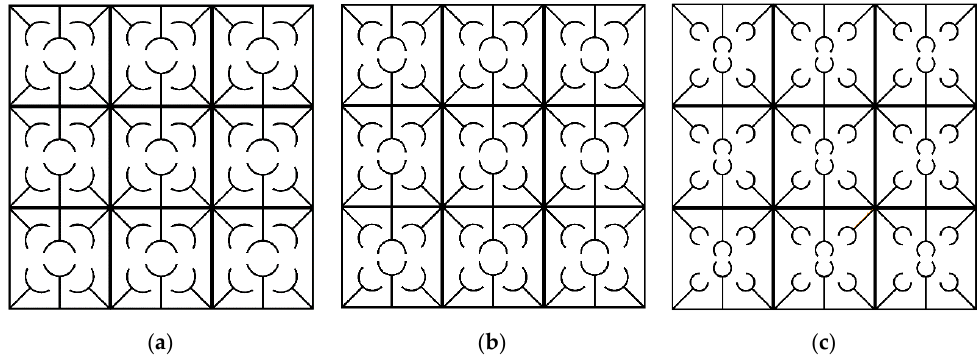
Figure 12. The configuration of adaptive periodic diagonal metastructure after heating–cooling process for three different printing speeds: ( a ) 20, ( b ) 40, and ( c ) 70 mm/s.